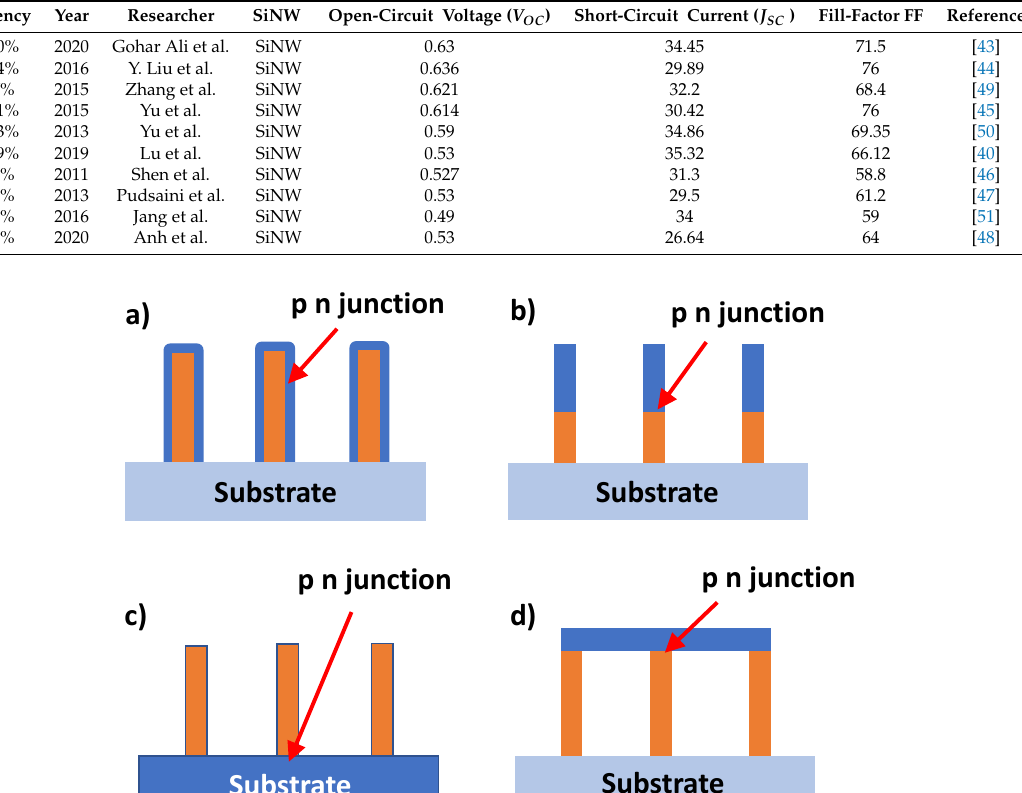
Figure 1. Different types of nanowire-based solar cells ( a ) radial p-n junction; ( b ) axial p-n junction; ( c ) substrate p-n junction and ( d ) stamped p-n junction solar cell. Radial p-n junction is the most favorable p-n junction for PEDOT:PSS–SiNW hybrid solar